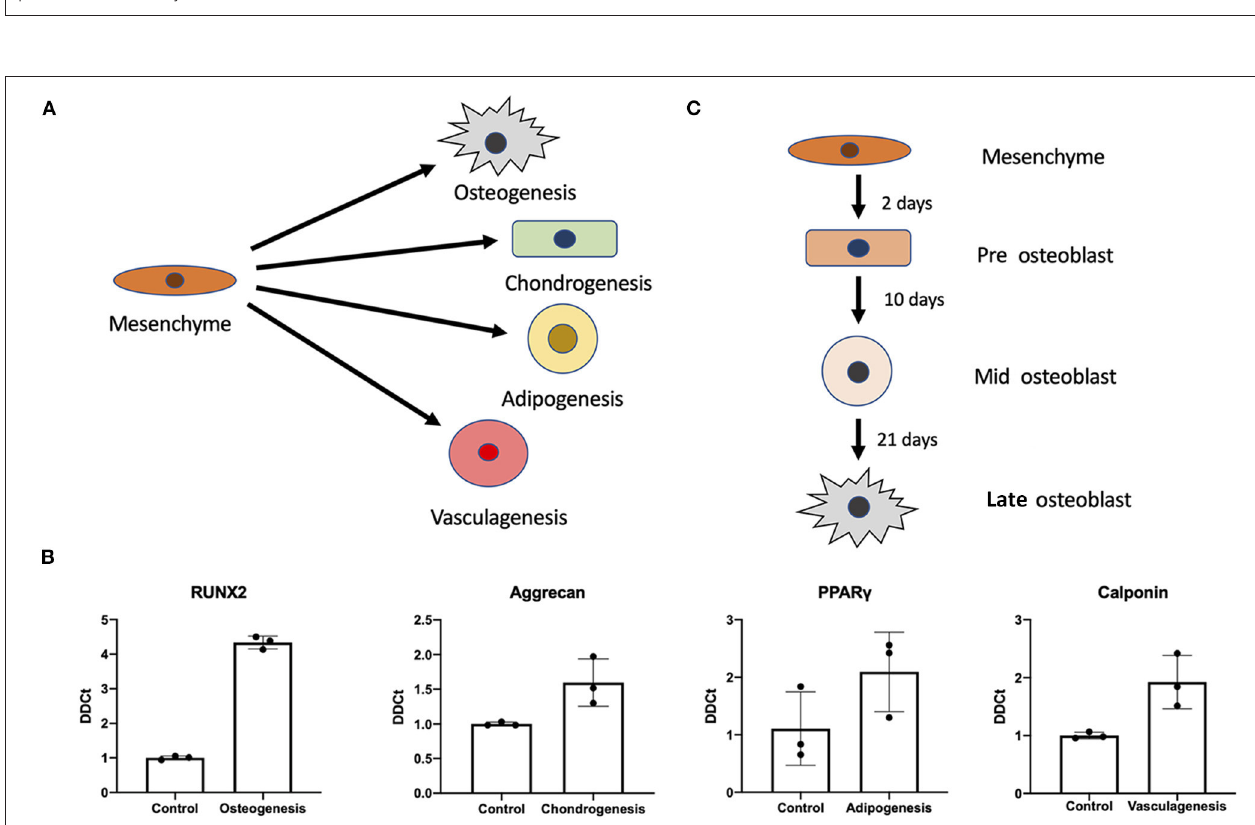
FIGURE 2 | Mesenchymal stem cell differentiation potential. Differentiation potential of mesenchymal stem cells. (A) Visual representation of the different cellular iMSCs have potential to generate (osteogenic, chondrogenic, adipogenic, and vasculagenic lineages). RT-qPCR confirms differentiation of these four lineages by expression of commonly used markers RUNX2, aggrecan, PPARgamma, calponin (respectively) (B) . Variant time course of osteoblastic differentiation that was interrogated to check time points for pre-osteoblast, mid-osteoblast and mature osteoblast phenotype (C) .